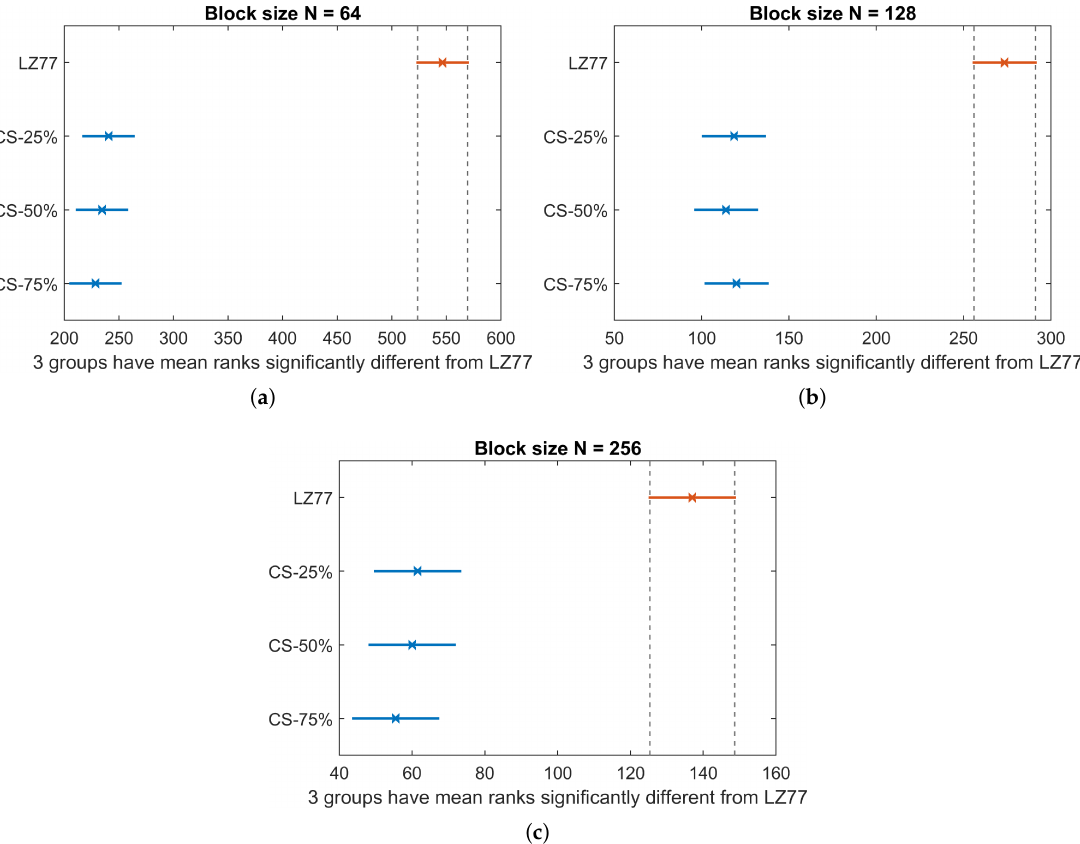
Figure 10. CET Kruskal–Wallis mean ranks and Dunn comparison intervals for different compression types: ( a ) N = 64; ( b ) N = 128; and ( c ) N = 256.